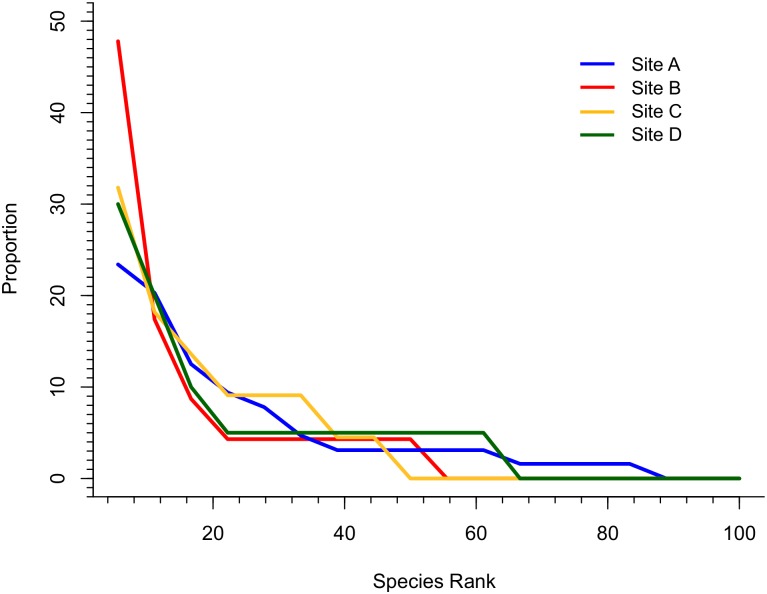
Rank Abundance Curves for Siltstone and Sandstone Assemblages.Proportion of specimens identified to a particular taxon plotted by abundance rank. The sites have been divided into sandstone and siltstone hosted groupings. Proportions given as percent of total number of specimens. Taxon ranked by proportion of the total number of taxa.